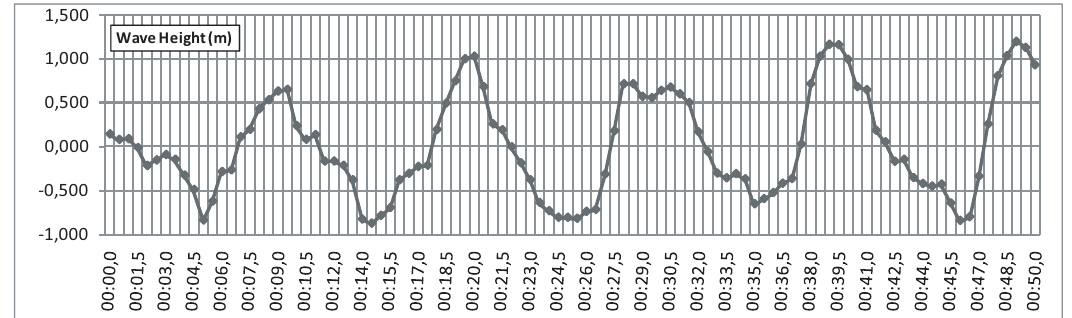
Figure 17. Considered real wave data to the wave-to-wire model